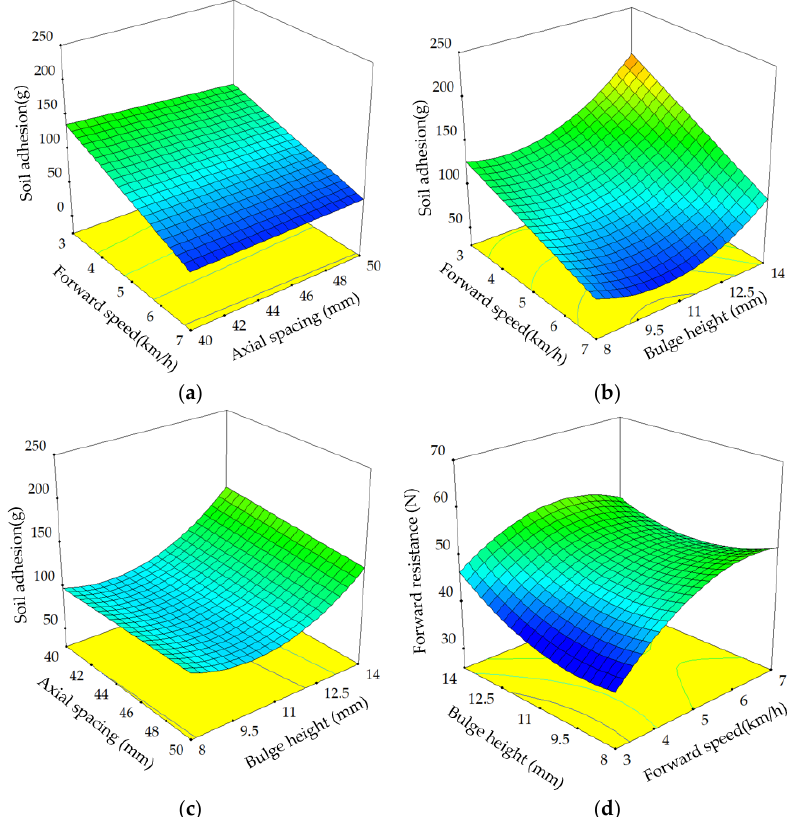
Figure 10. Response surfaces between factor interactions and indexes: ( a ) Y 1 ( x 1 , x 2 ,11 mm); ( b ) Y 2 ( x 1 ,45 mm, x 3 ); ( c ) Y 1 (5 km/h, x 2 , x 3 ); ( d ) Y 2 ( x 1 ,45 mm, x 3 ).